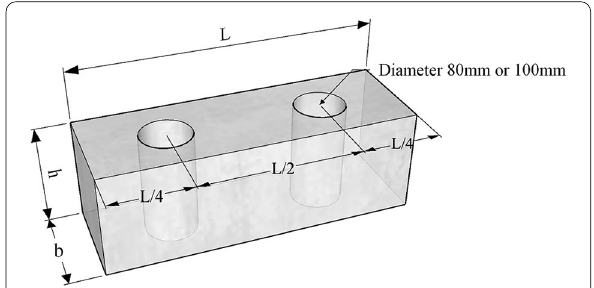
Fig. 1 AAC blocks with holes at quarter span point.